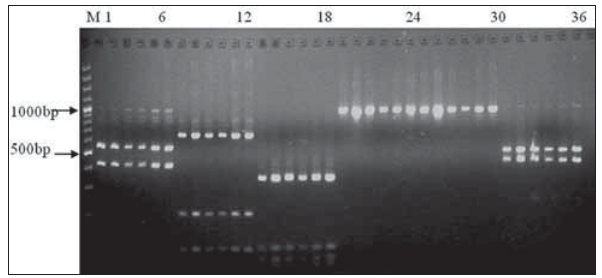
Figure-1: Screening of mitochondrial cytochrome b of sheep pooled DNA revealed by four restriction enzyme.